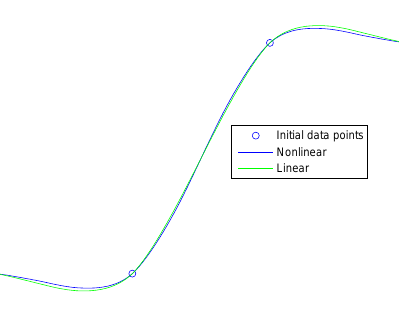
Figure 3. Initial control points and curve generated by 5-point linear ternary interpolating subdivison scheme (5th level) in (9) and 5-point nonlinear ternary interpolating subdivision scheme (11) with w =